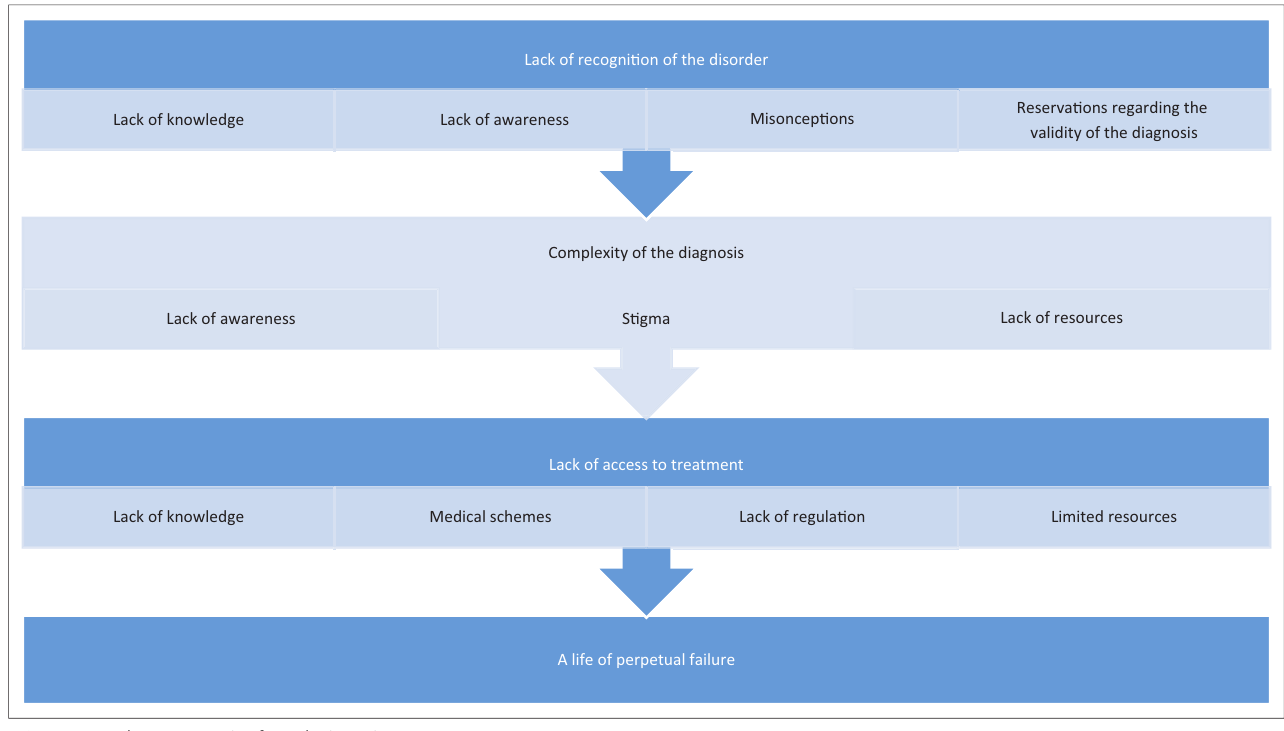
FIGURE 1: Key themes emerging from the